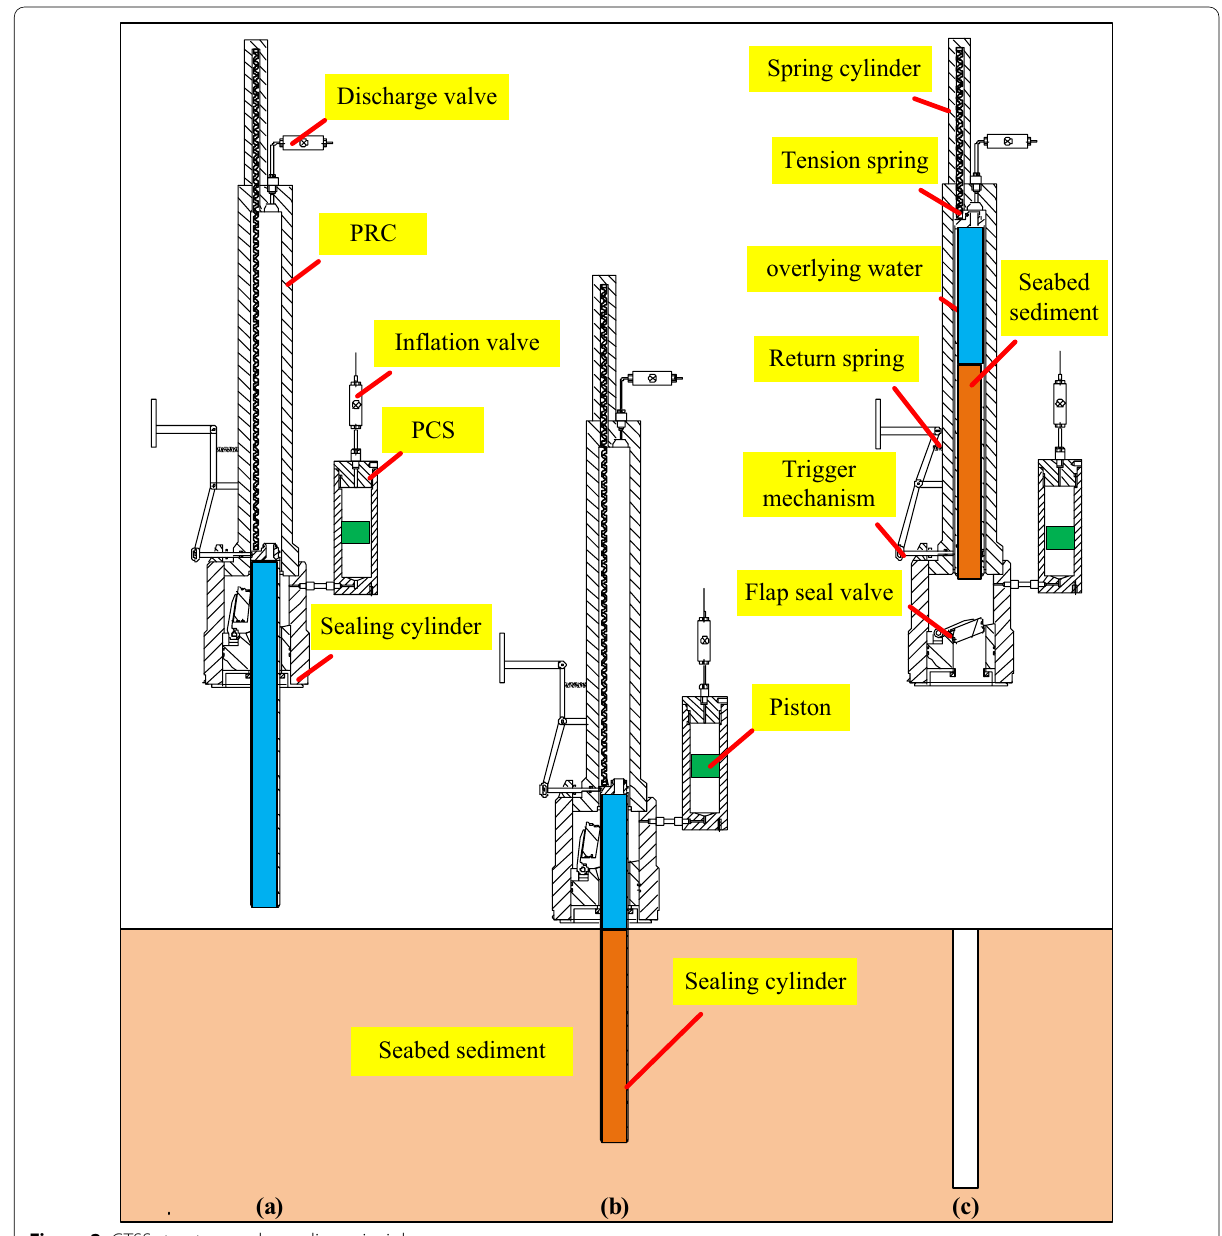
Figure 2 GTSS structure and sampling